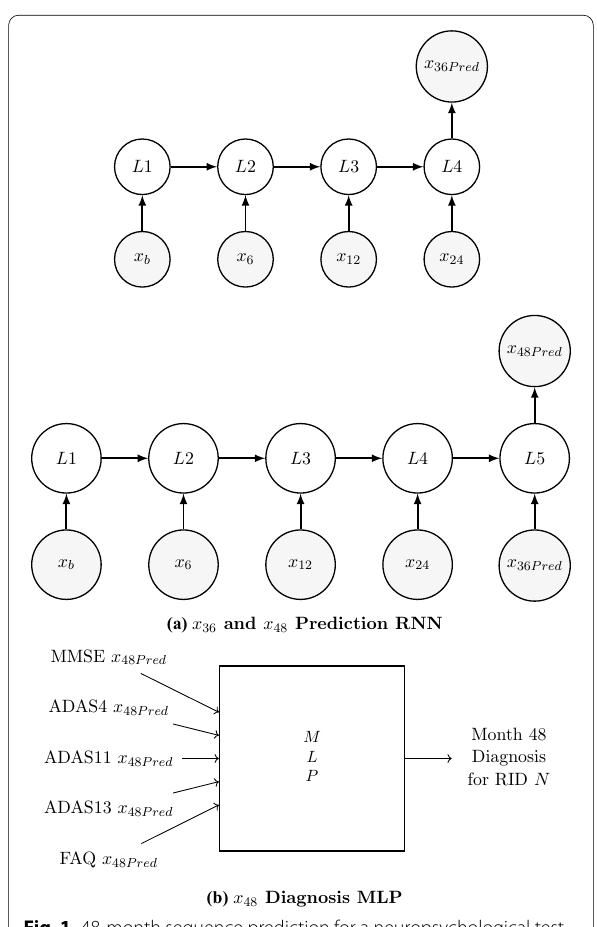
Fig. 1 48-month sequence prediction for a neuropsychological test for RID N